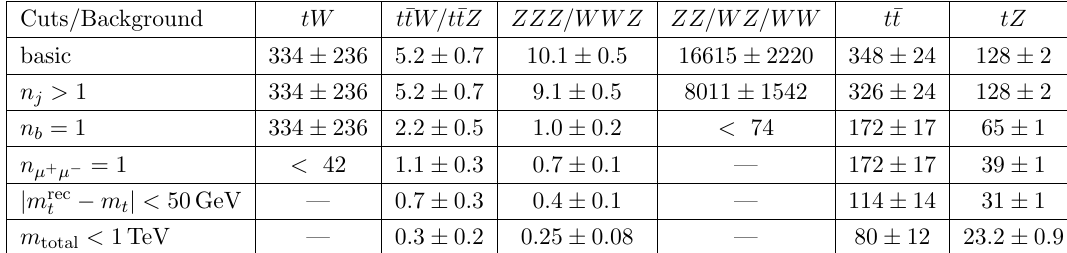
Table 3 . Event yields after each cut for the dominant backgrounds, in the analysis for t ! Sq; S ! The event yields presented assume a collected luminosity of L = 150 fb (cid:0) 1 . Background/ m S